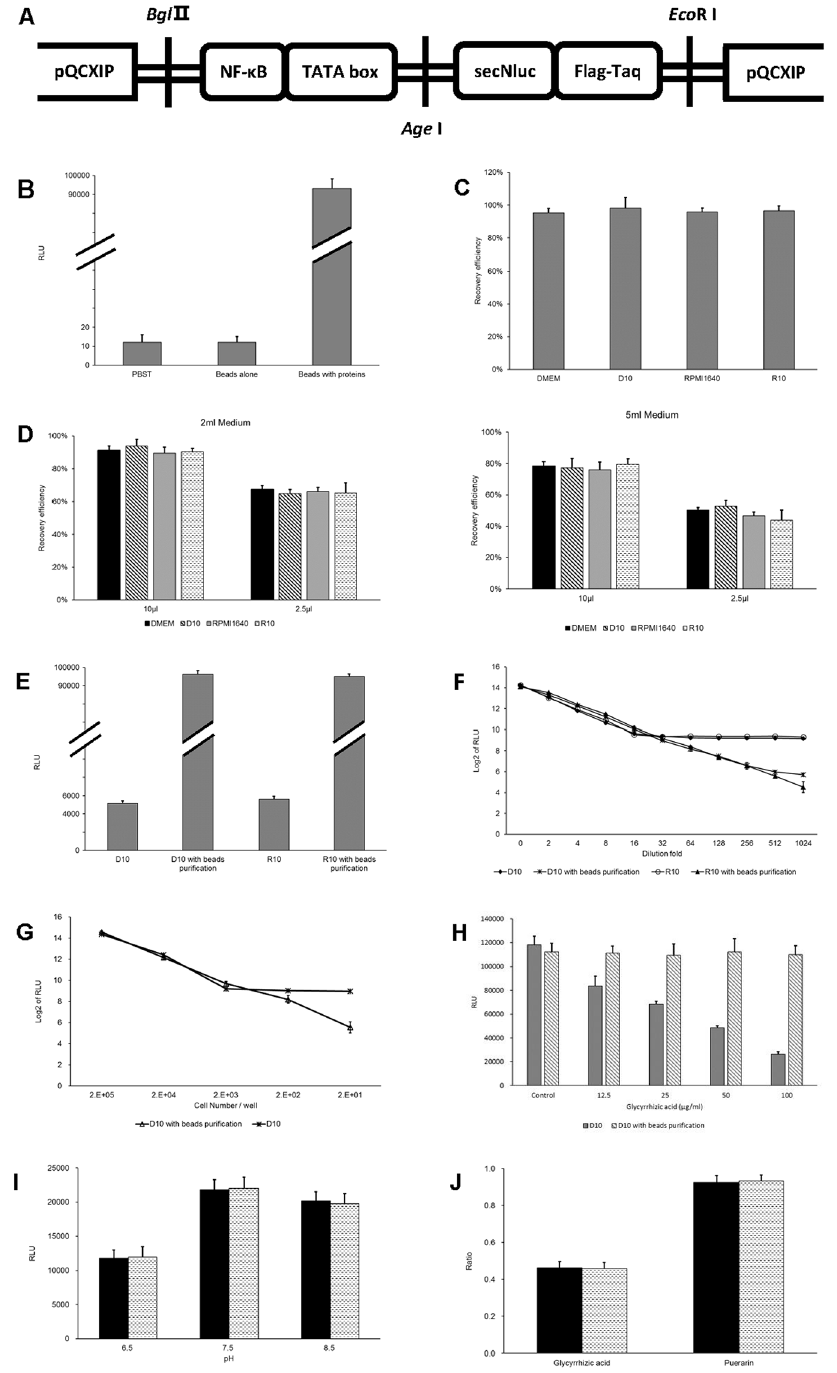
Fig 3. A purification strategy employing secNluc-FLAG fusion proteins and anti-FLAG magnetic beads for optimizing the application of secNluc reporter system. (A) Schematic representation of the constructed pQCXIP-NF- κ B-secNluc-FLAG plasmid. (B) Luminescence signals induced by anti-FLAG beads. 2.5 μl of anti-FLAG beads were added to 100 μ l of PBST containing 3 μ mol/l coelenterazine to measure the luminescence signals induced by the beads. Additionally, 2.5 μl of beads binding secNluc-FLAG fusion proteins was used as the positive control, and PBST containing coelenterazine alone was used as the negative control. (C) and (D) Recovery of secNluc-FLAG proteins in different media after purification with anti-FLAG beads. 2.5 μl of beads were mixed with 100 μl of four different media containing the secreted secNluc-FLAG protein (C). Similarly, 2.5 μl and 10 μl of beads were mixed